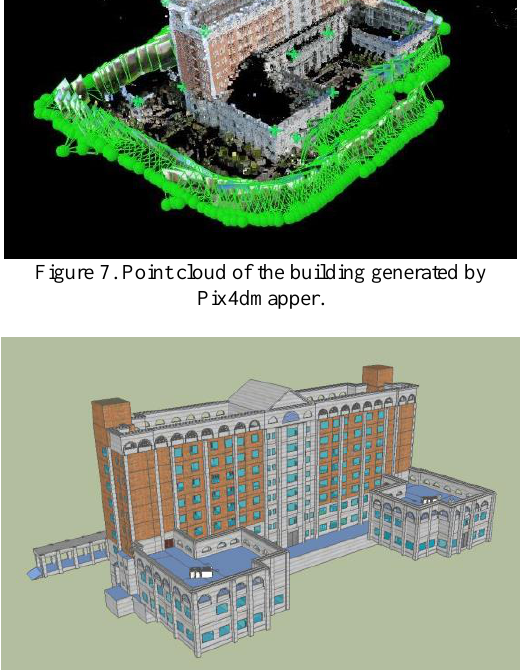
Figure 8. Building model generated from the point cloud by AutoCAD 2016 and SketchUp Make 2016. Figure 9. 3D building model created for a real environment by using the predefined marker in AR: (a) marker of the real graph; (b) the 3D building model displayed on a mobile phone by using the Unity app; (c) interior spatial arrangement of the selected floor; (d) the main designs of the interaction functions, which include object manipulation and information